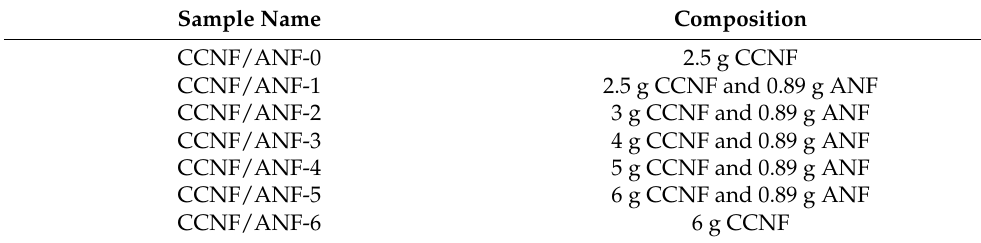
Table 1. Composition of as-prepared